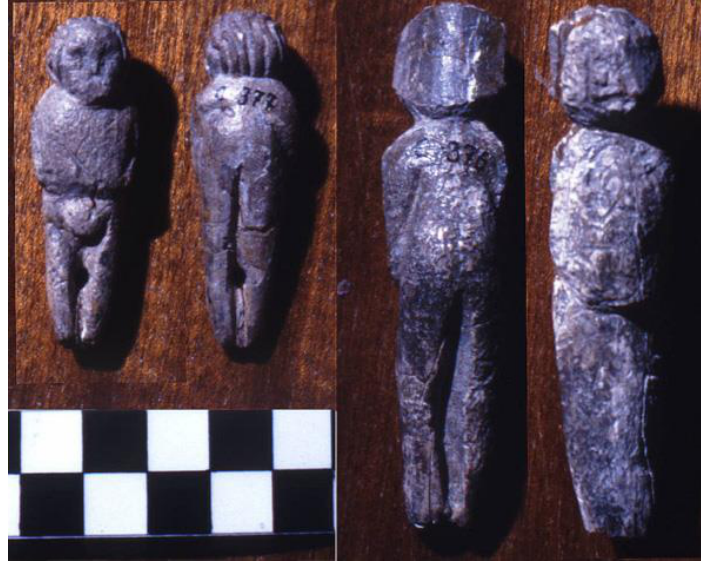
Figure 2. Numbers 3 (left) and 4 of the ivory figurines from Buret’, central Siberia, each seen from front and back; scale in